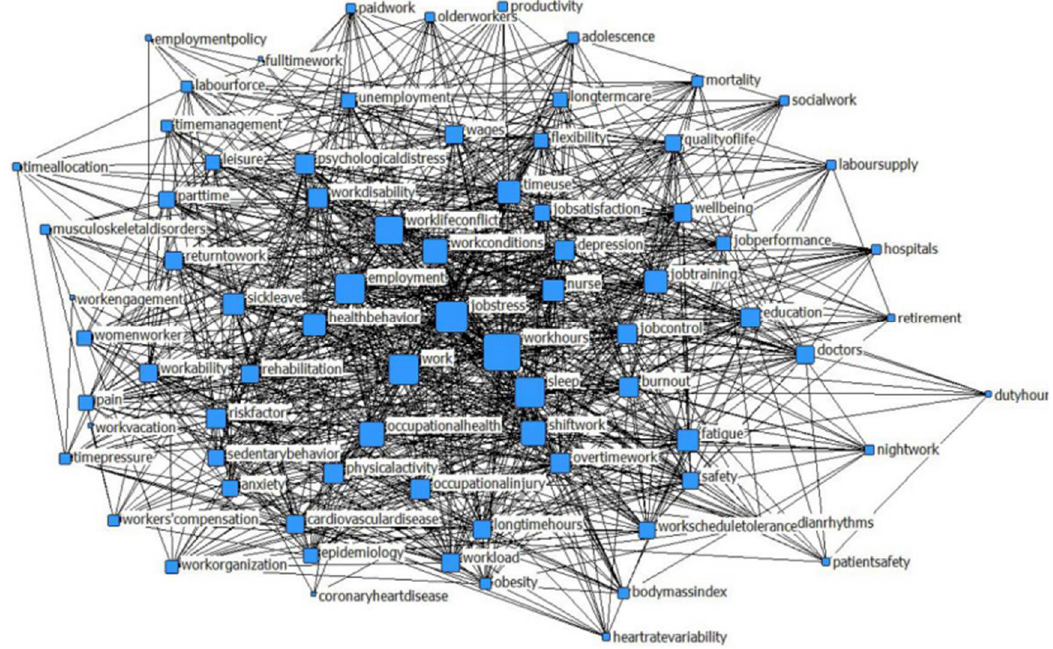
Figure2. Co-occurrence network of high-frequency keywords. Figure 2. Co-occurrence network of high-frequency